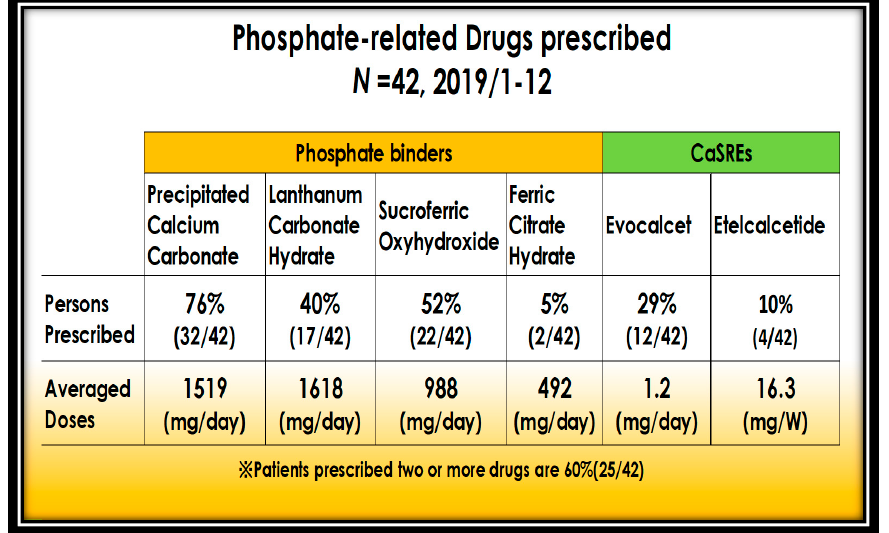
Figure 8. Use of P-binders and CSREs. Another key to managing serum phosphorus is to properly manage bone remodeling and mobilize calcium phosphate to the bone. Phosphorus and w-PTH are correlated, so managing at the lower end of the appropriate range for w-PTH can lower phosphorus (Figure 9).